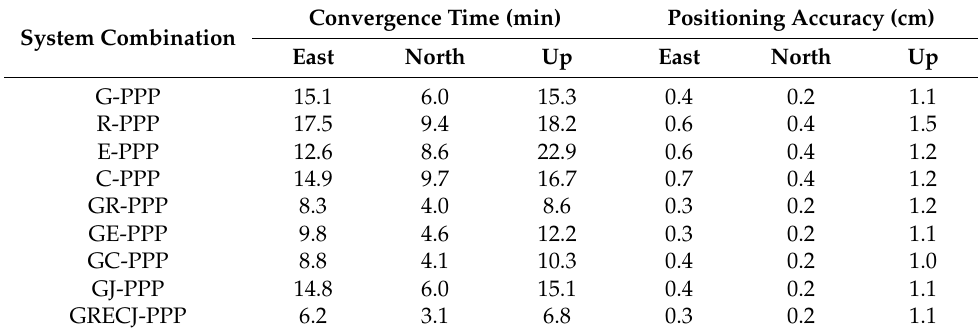
Table 9. Static positioning accuracy and convergence time of post-processed PPP (long-term perfor- mance of PPP based on daily observations) with WHU products for different system combinations using the datasets from 29 stations spanning a week.